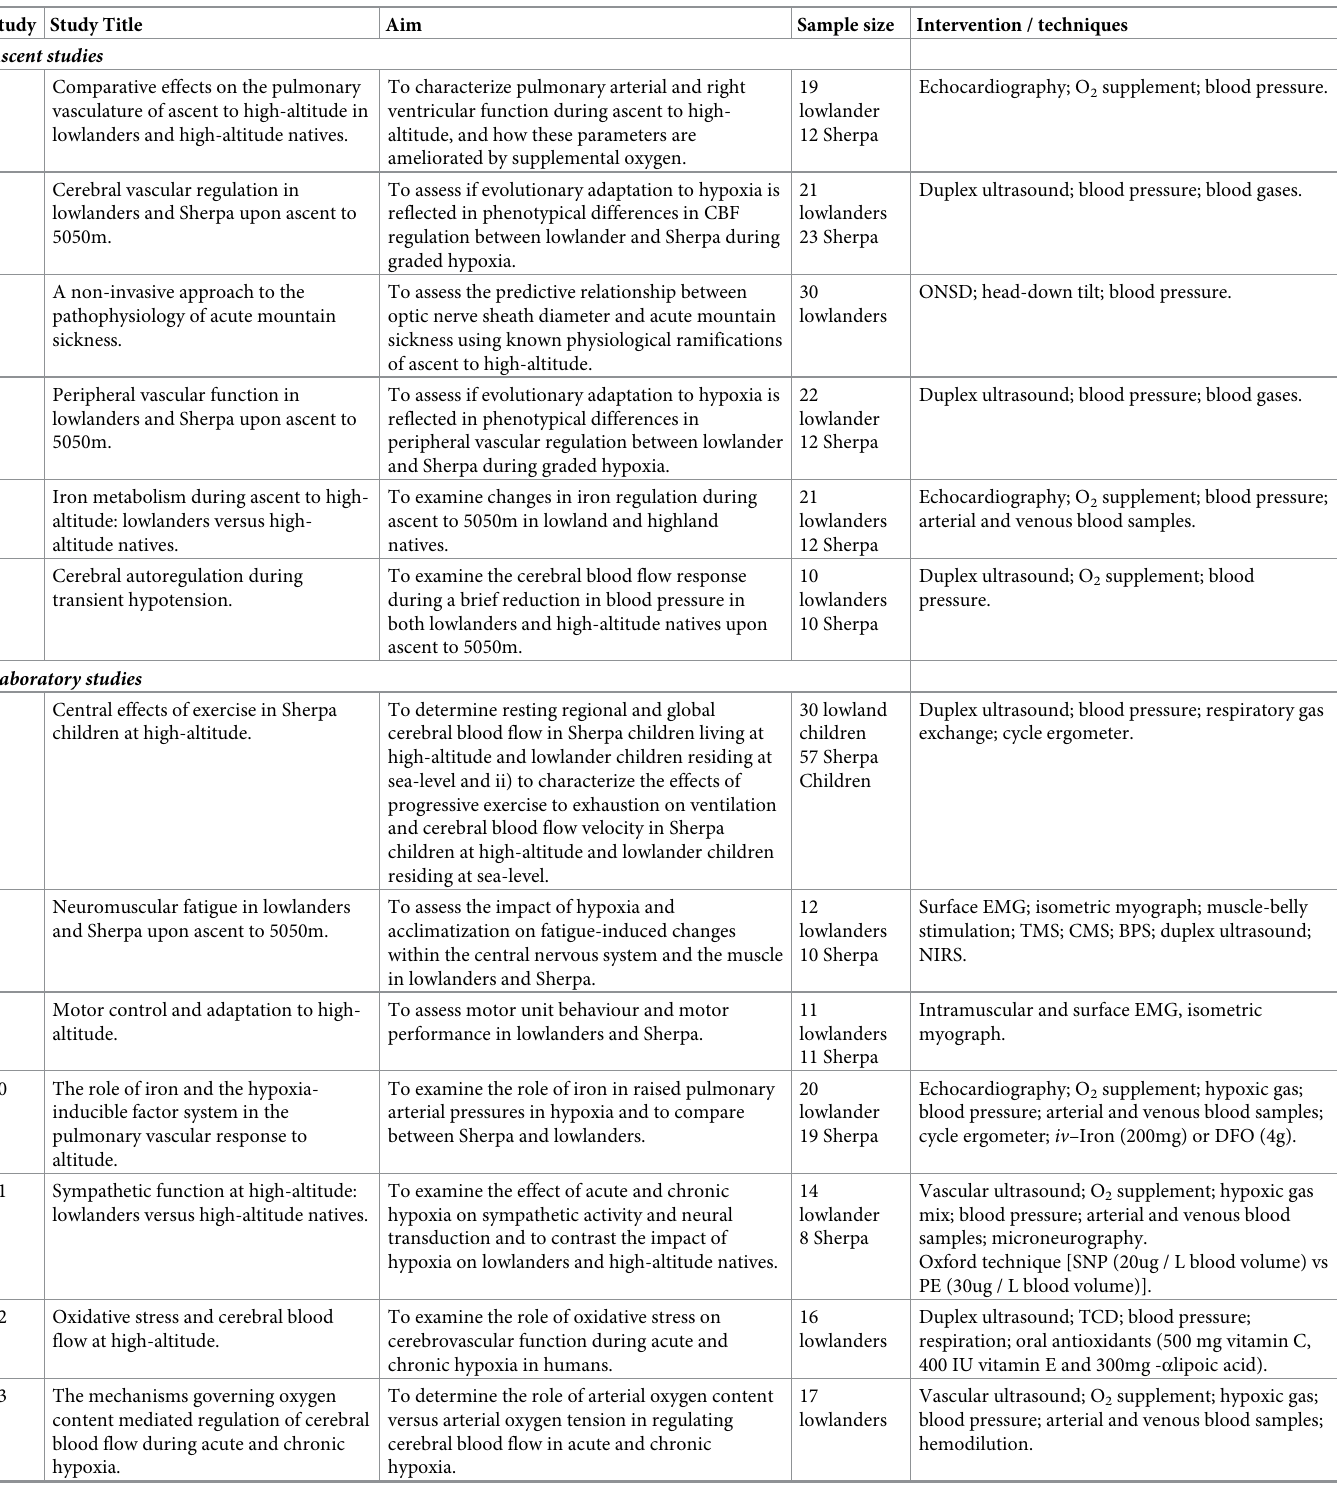
Table 1. Core studies conducted on the UBC expedition, including objectives, key measures and sample